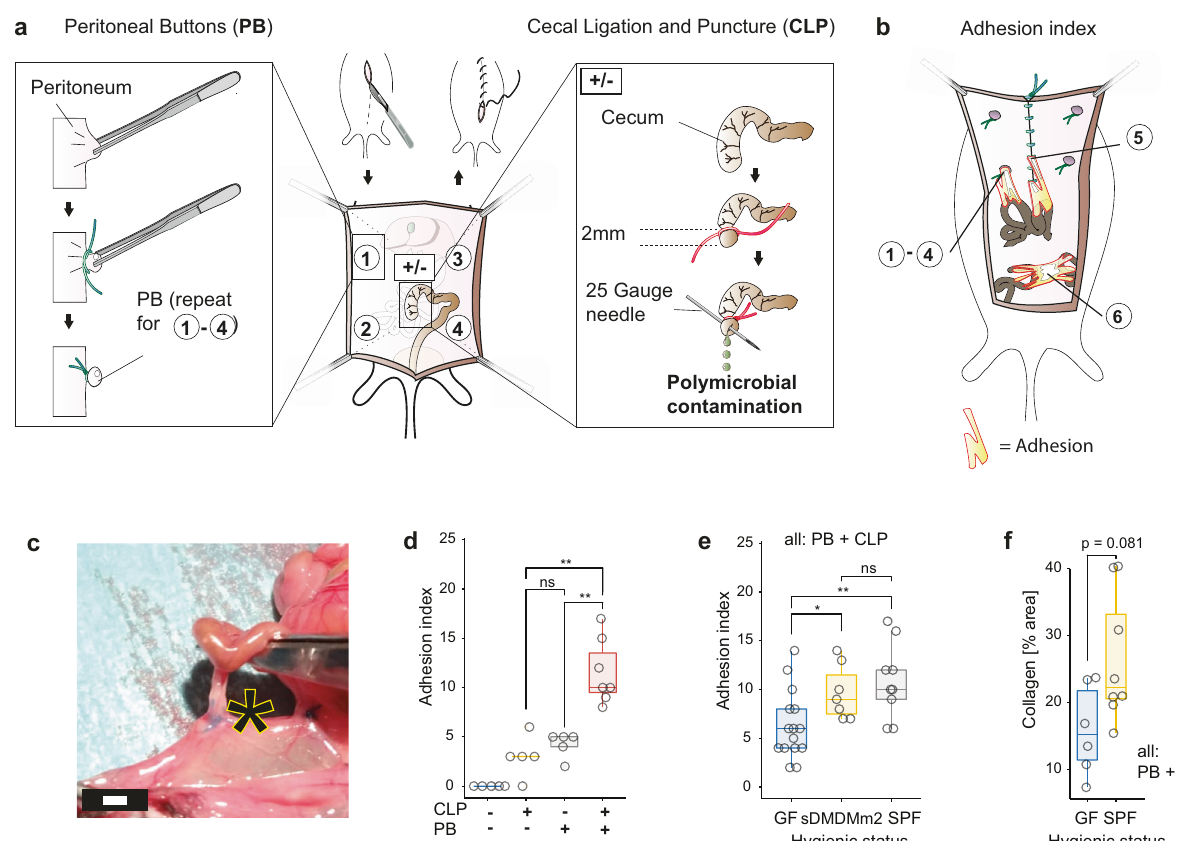
Fig. 1 Surgical injury and microbe contamination augment post-surgical peritoneal adhesions. a C57BL/6(J) mice were surgically injured by applying two peritoneal buttons (PB) per side (left panel) in combination with or without microbial contamination through cecal ligation and puncture (CLP) (right panel). b Surgical model resulted in the formation of peritoneal adhesions within 7 days post-surgery. Adhesions were scored for tenacity